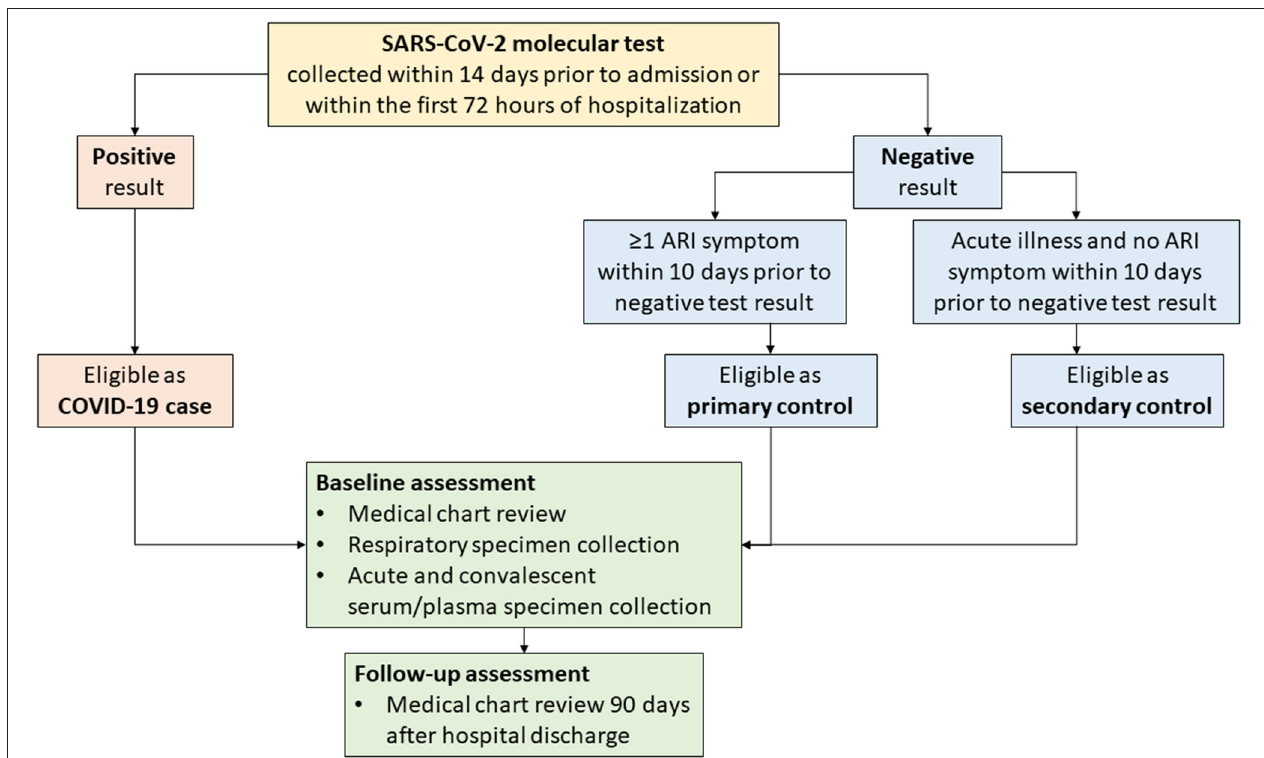
FIGURE 3 | Flow diagram for COVID-19 surveillance data collection—Surveillance Platform for Enteric and Respiratory Infectious Organisms at Veterans Affairs Medical Centers (SUPERNOVA), 2021. ARI, acute respiratory illness.